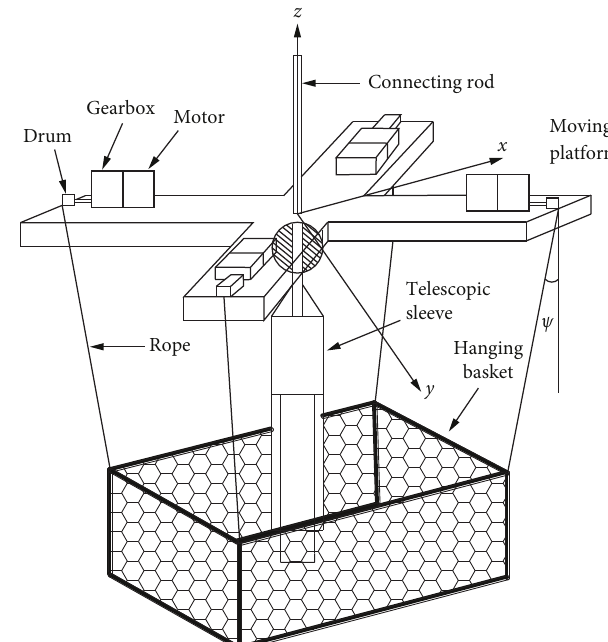
F IGURE 7: Batch transfer hanging basket system with telescopic sleeve.